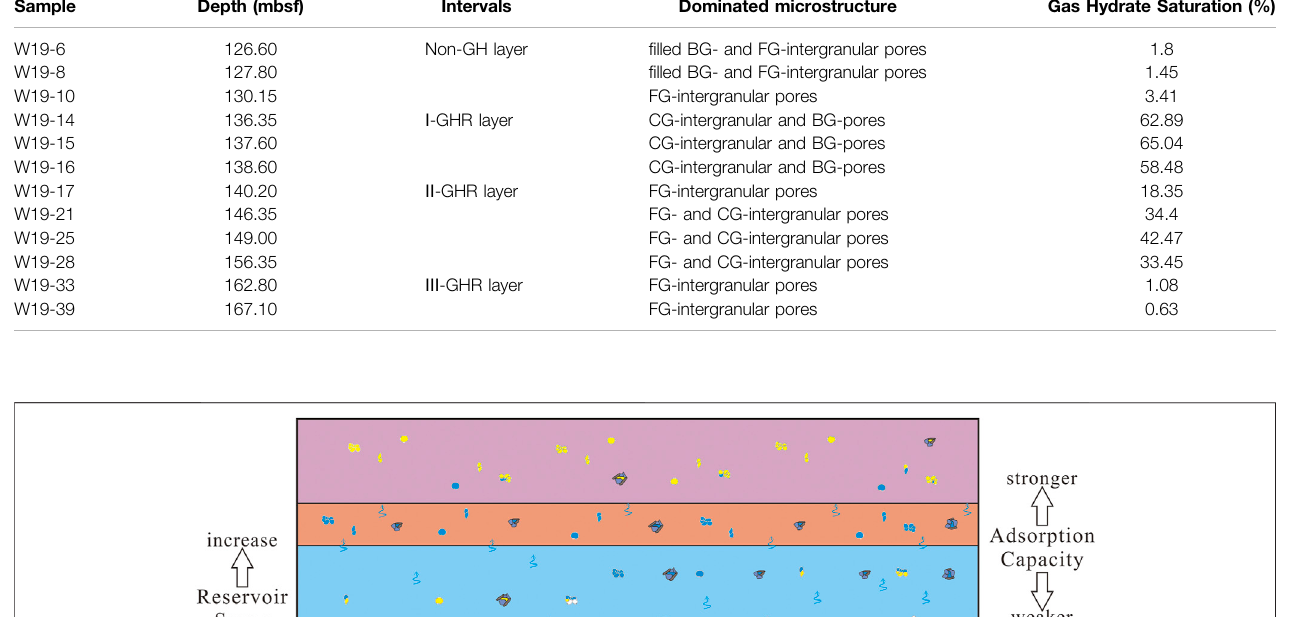
TABLE 4 | The microstructure types and gas hydrate saturation of samples. Sample